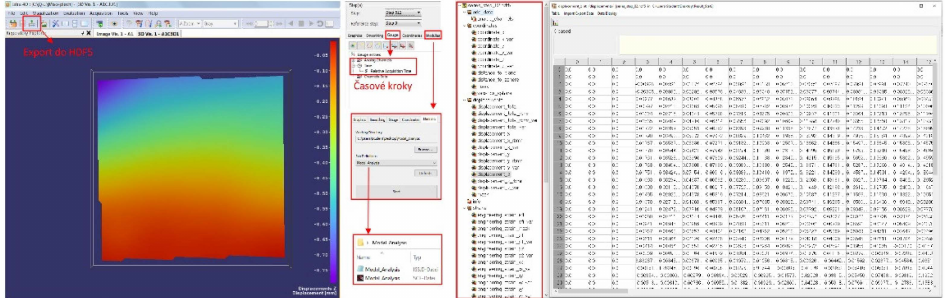
Figure 7. ISTRA 4D working environment and .HDF5 file matrices for time step 82.